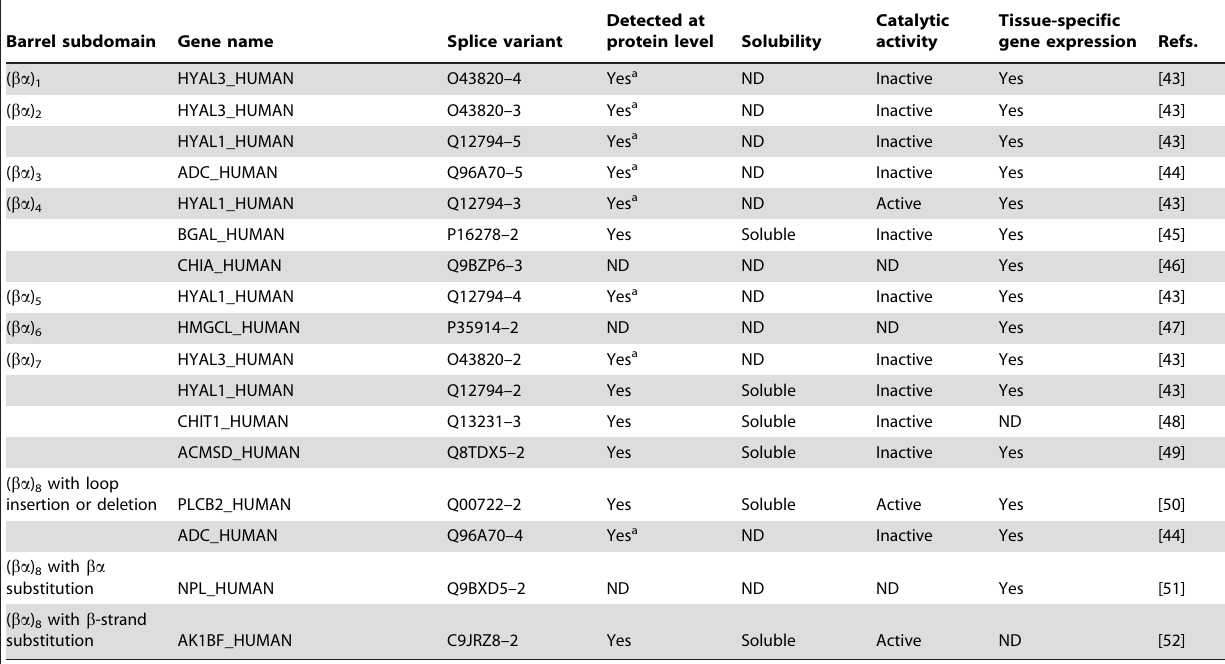
Table 2. Functional annotations of human splice